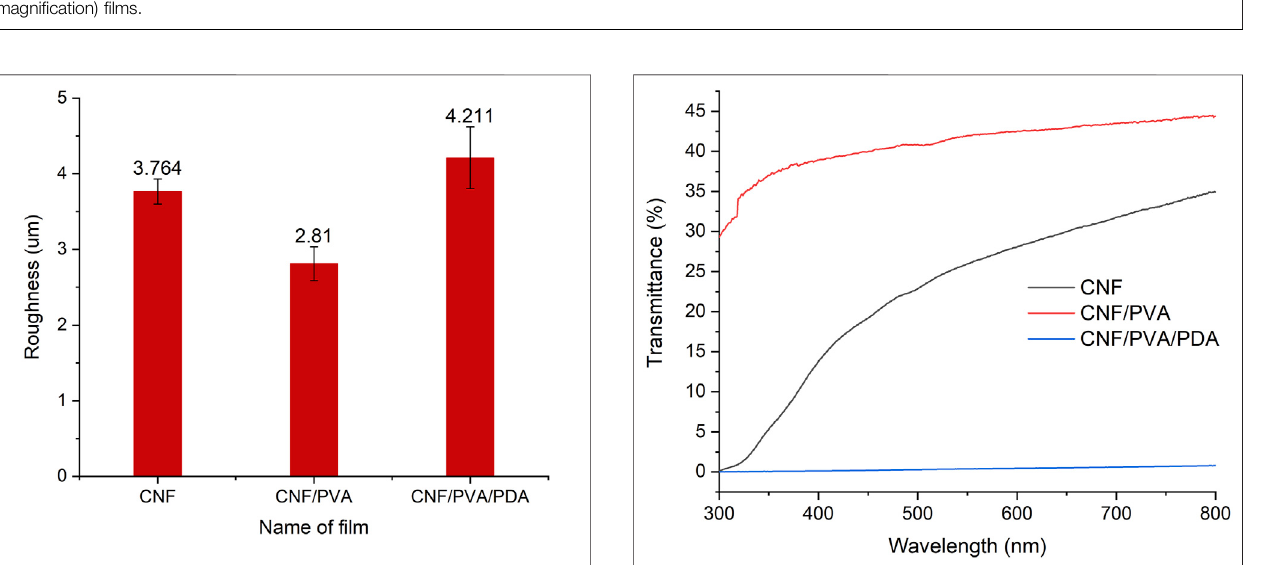
FIGURE 4 | Roughness of CNF, CNF/PVA and CNF/PVA/PDA fi lms.